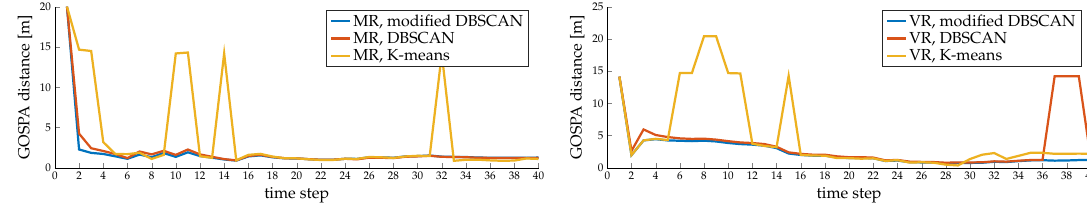
( d ) The comparison of mapping results for VR among three clustering algorithms. Figure 9. Comparison of GOSPA results among three clustering